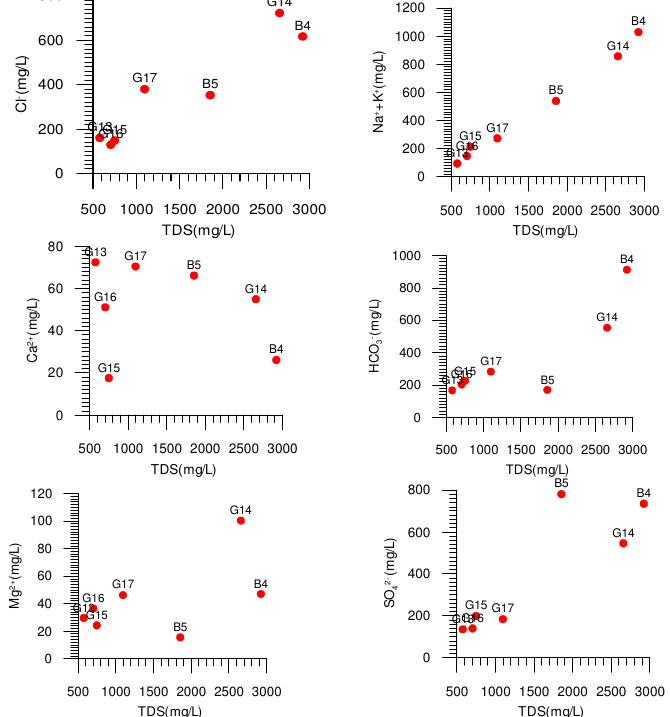
Figure 6. The relation between TDS and the concentrations of major